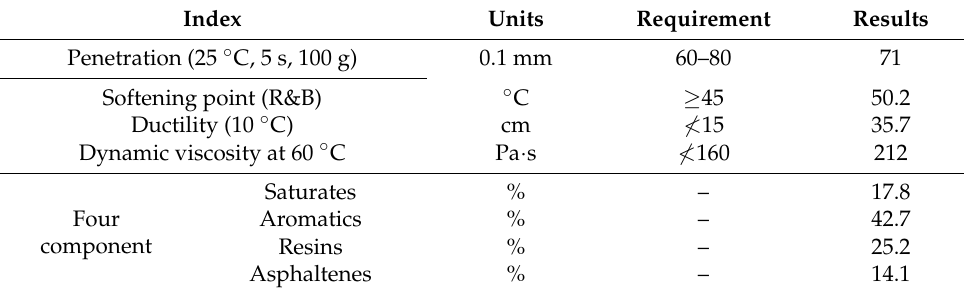
Table 1. Conventional Index of Qinhuangdao AH-70